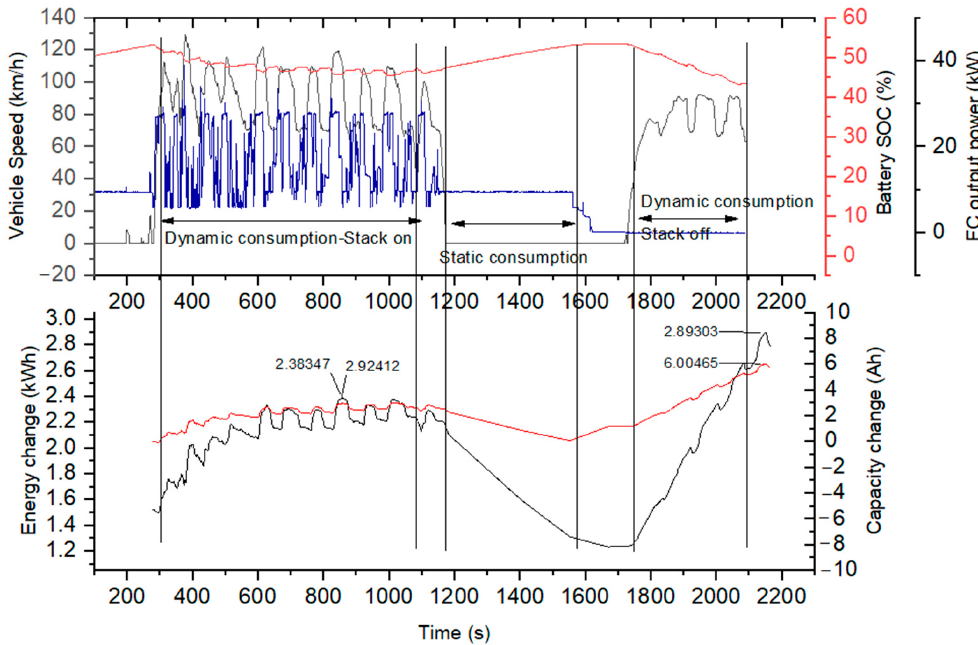
Figure 10. Battery SOC, Energy change, and Capacity change.